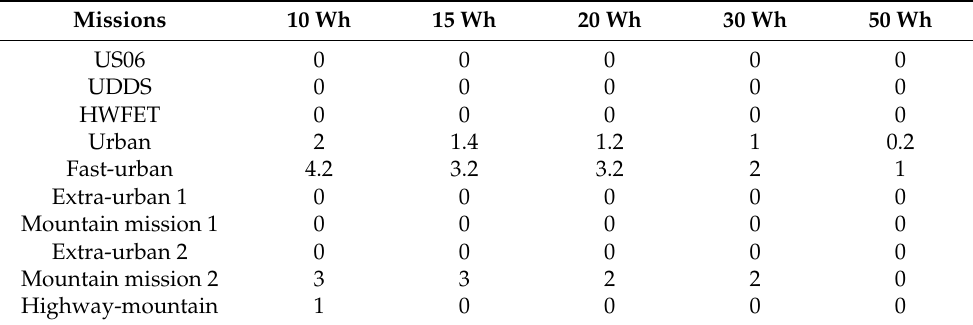
Table 9. Number of engine starts, approximated to the nearest integer, when speed is below the Upper Speed Limit (USL), as a function of LSZ sizing (expressed in Wh).